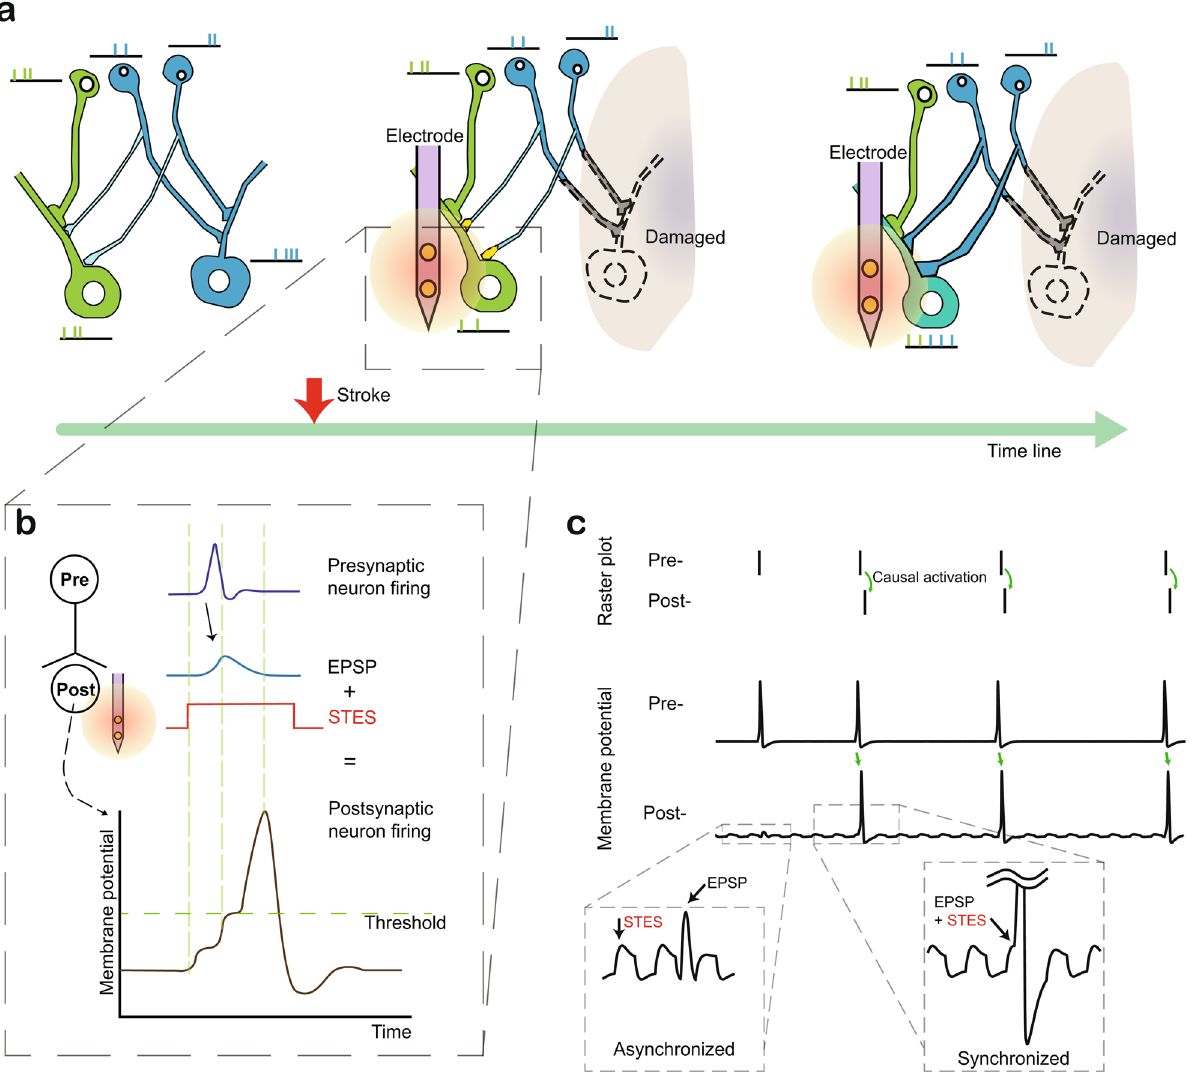
Figure 1. Synaptic remapping by electrical stimulation after stroke. ( a ) The connection between pre- and postsynaptic neurons are rebuilt by stroke and electrical stimulation. After stroke newly made connections are strengthened by electrical stimulation. ( b ) Incoming EPSP from presynaptic neurons and additional potential provided by STES induces a postsynaptic action potential following the presynaptic action potential. ( c ) The upper graph, raster plot, displays the spike timing at pre- and postsynaptic neuron (Pre- and Post- respectively). The bottom graph is the simulation result of two connected neurons with STES. When STES and presynaptic activation occur asynchronously, postsynaptic neurons do not fire (left-highlighted square). When presynaptic firing and STES occur together, postsynaptic fire followed presynaptic neuron activation (right highlighted